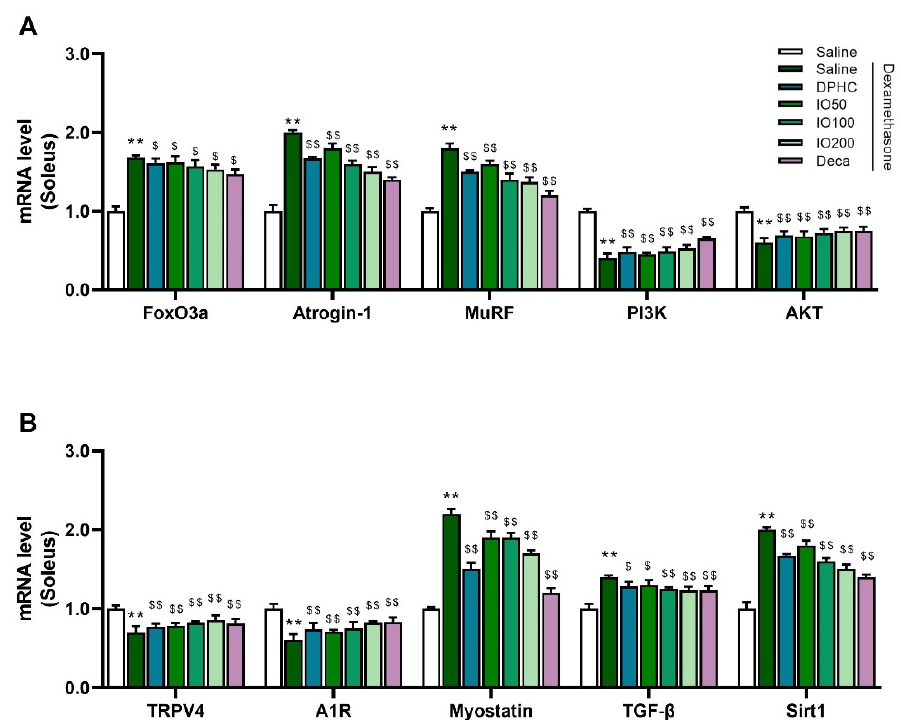
Figure 5. Levels of mRNA related to protein degradation and muscle growth in soleus muscle of DEX-treated mice displaying muscle atrophy. The panels display results for FoxO3a, Atrogin-1, MuRF, PI3K, and AKT ( A ), TRPV4, A1R, Myostatin, TGF- β , and Sirt1( B ) are aligned in ( B ). Each group was examined in n = 3 mice. All values are expressed as the mean ± standard error. Significant differences are indicated as ** p < 0.01 compared with control or $ p < 0.05, $$ p < 0.01 compared with DEX-saline (Mann–Whitney U test).